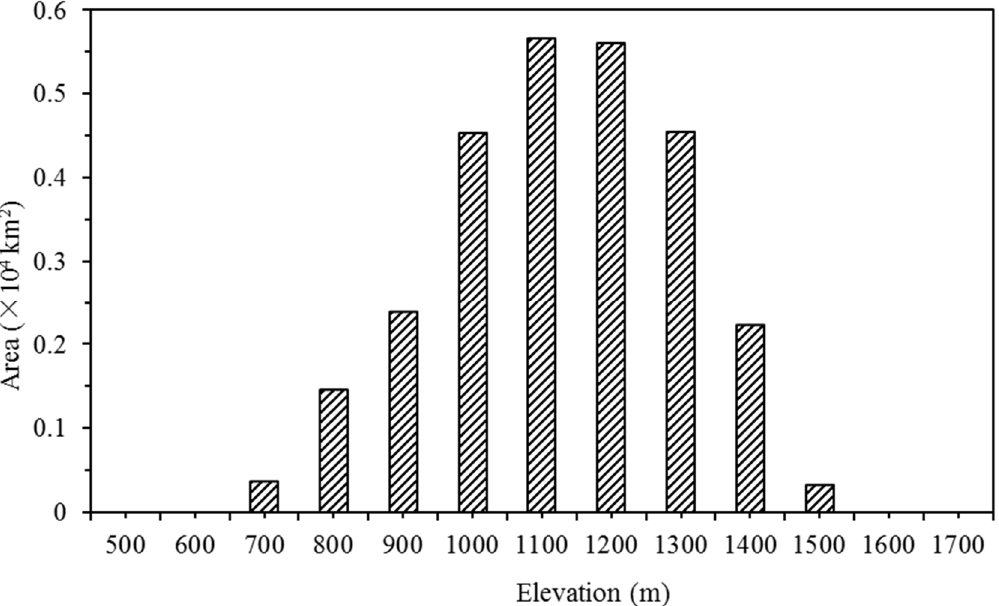
Figure 8. Distribution of tropical evergreen forests on different elevation gradients based on resampled 30-m digital elevation model in the study area of Xishuangbanna, Yunnan, China in 2010.